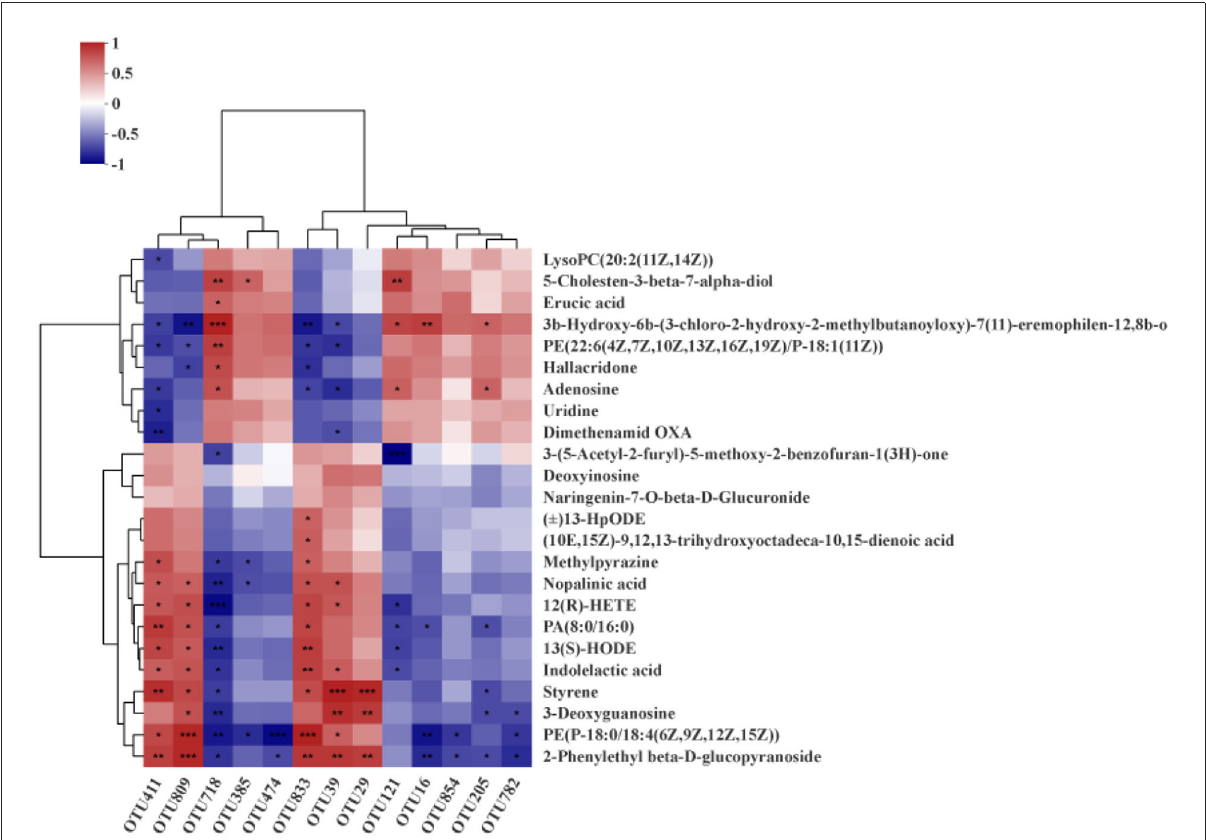
FIGURE9 Spearman’s correlation analysis between hepatic metabolites and gut microbiota (OTU level). * P < 0.05; ** P < 0.01; *** P <